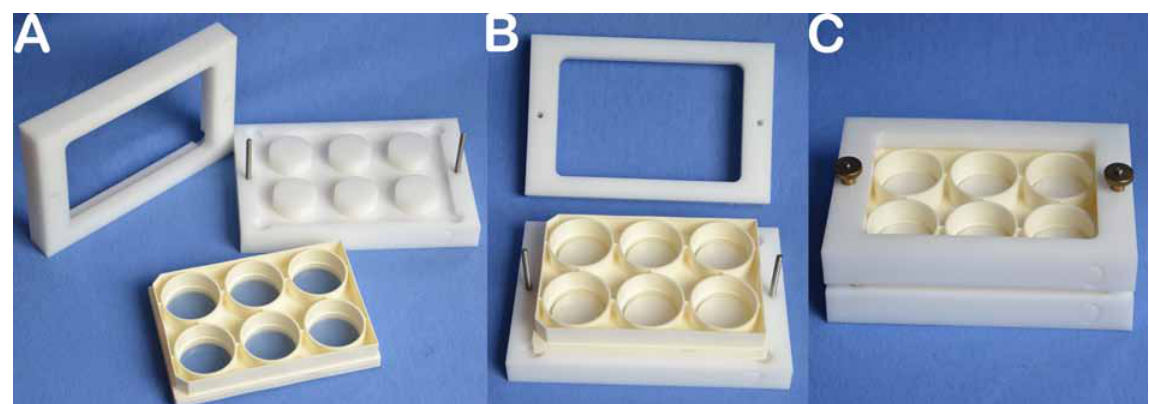
Figure 1. Device for application of tensile strain. (A) Components of the device (base plate with stamps, BioFlex® culture plate, cover). (B) BioFlex® culture plate placed on the base plate. (C) Assembled device with the coverlid on